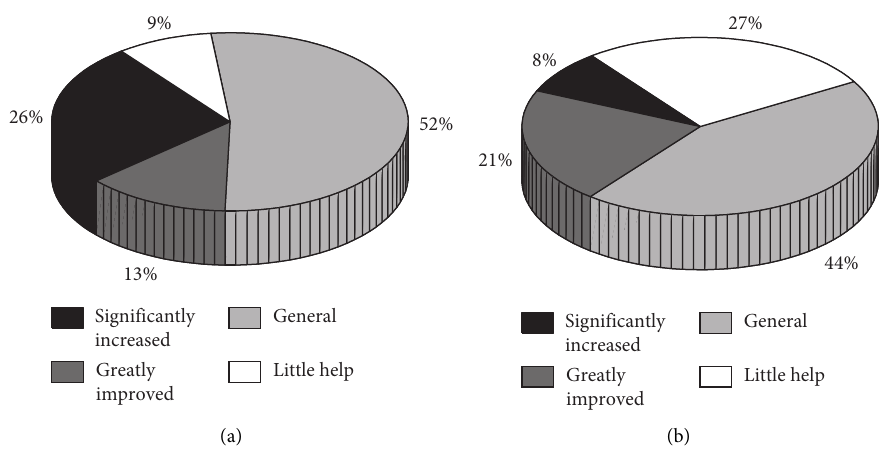
Figure 11: How helpful the teaching mode is to the learning effect? (a) Experimental class. (b) Control